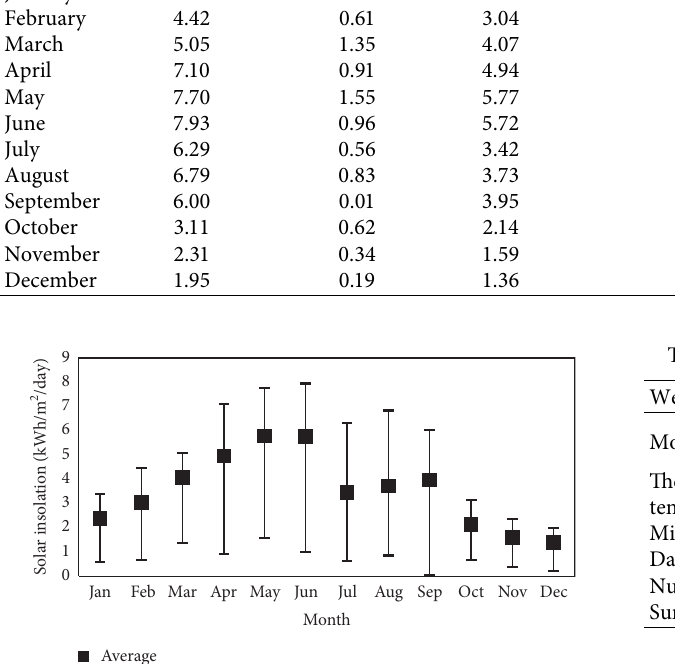
Figure 4: Range of monthly solar insolation by measured data from the meteorological administration.